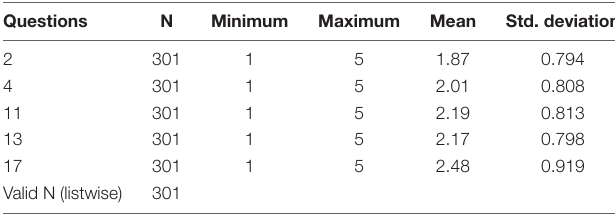
TABLE 3 | Descriptive statistics of the questions related the efficacy of technology-integrated classrooms.